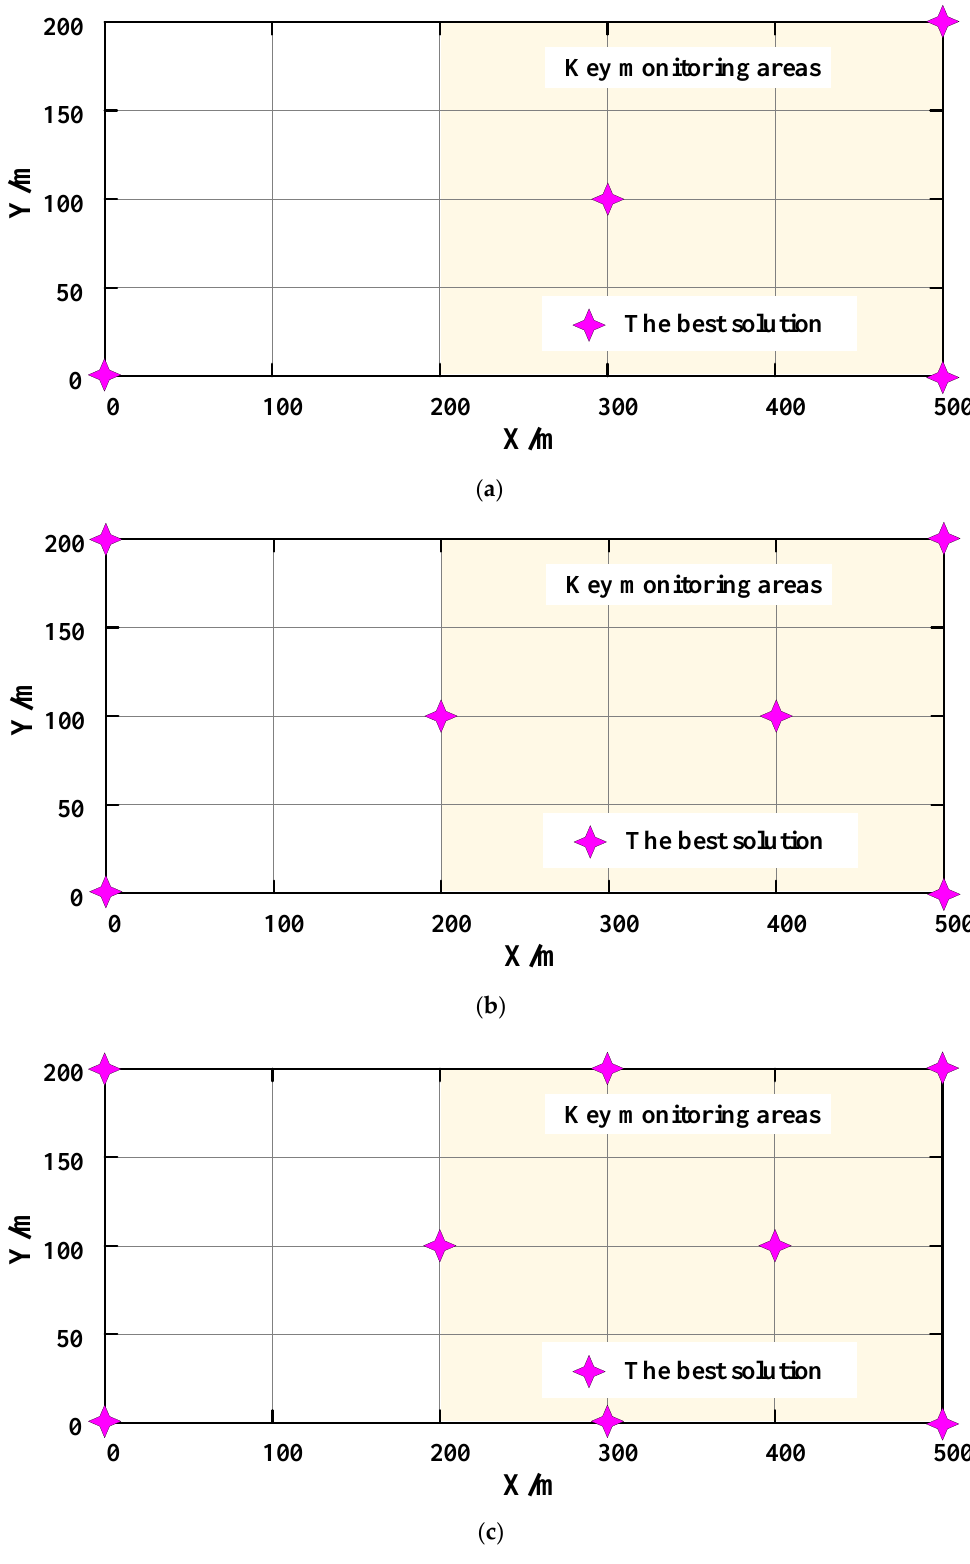
Figure 4. Network configuration results solved by IPSO and SA. ( a ) Solution Results of Scheme I. ( b ) Solution Results of Scheme II. ( c ) Solution Results of Scheme III.